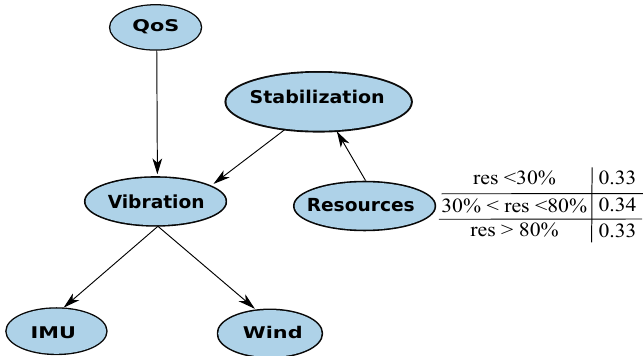
Figure 5. BN for Vibration Including Resource